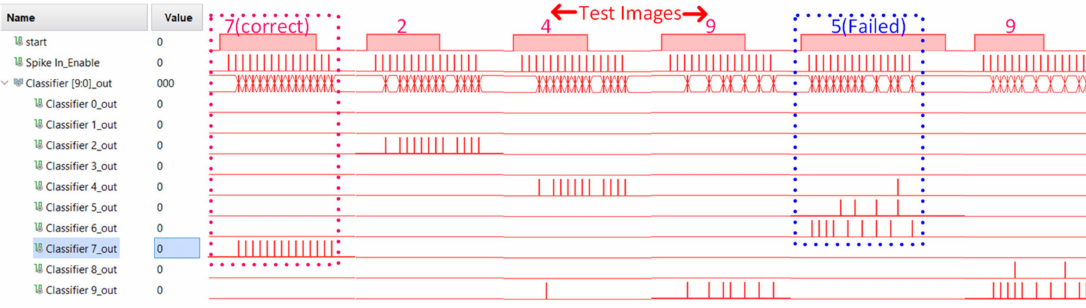
Figure 12. The measurement results for Digital SNN showing the correct classification of different input images along with the failed classification of input image ‘5’.